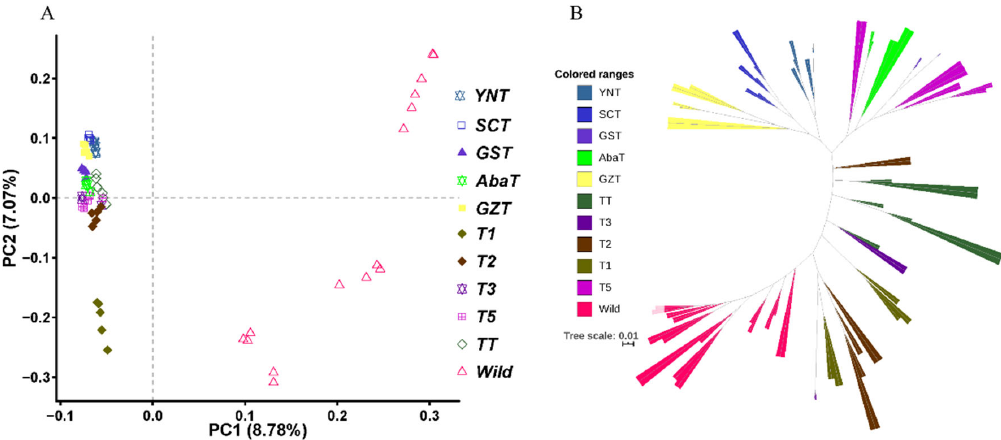
Figure 1. Principal component analysis ( A ) and the phylogenic tree ( B ) of 10 geographically isolated Tibetan pig populations.